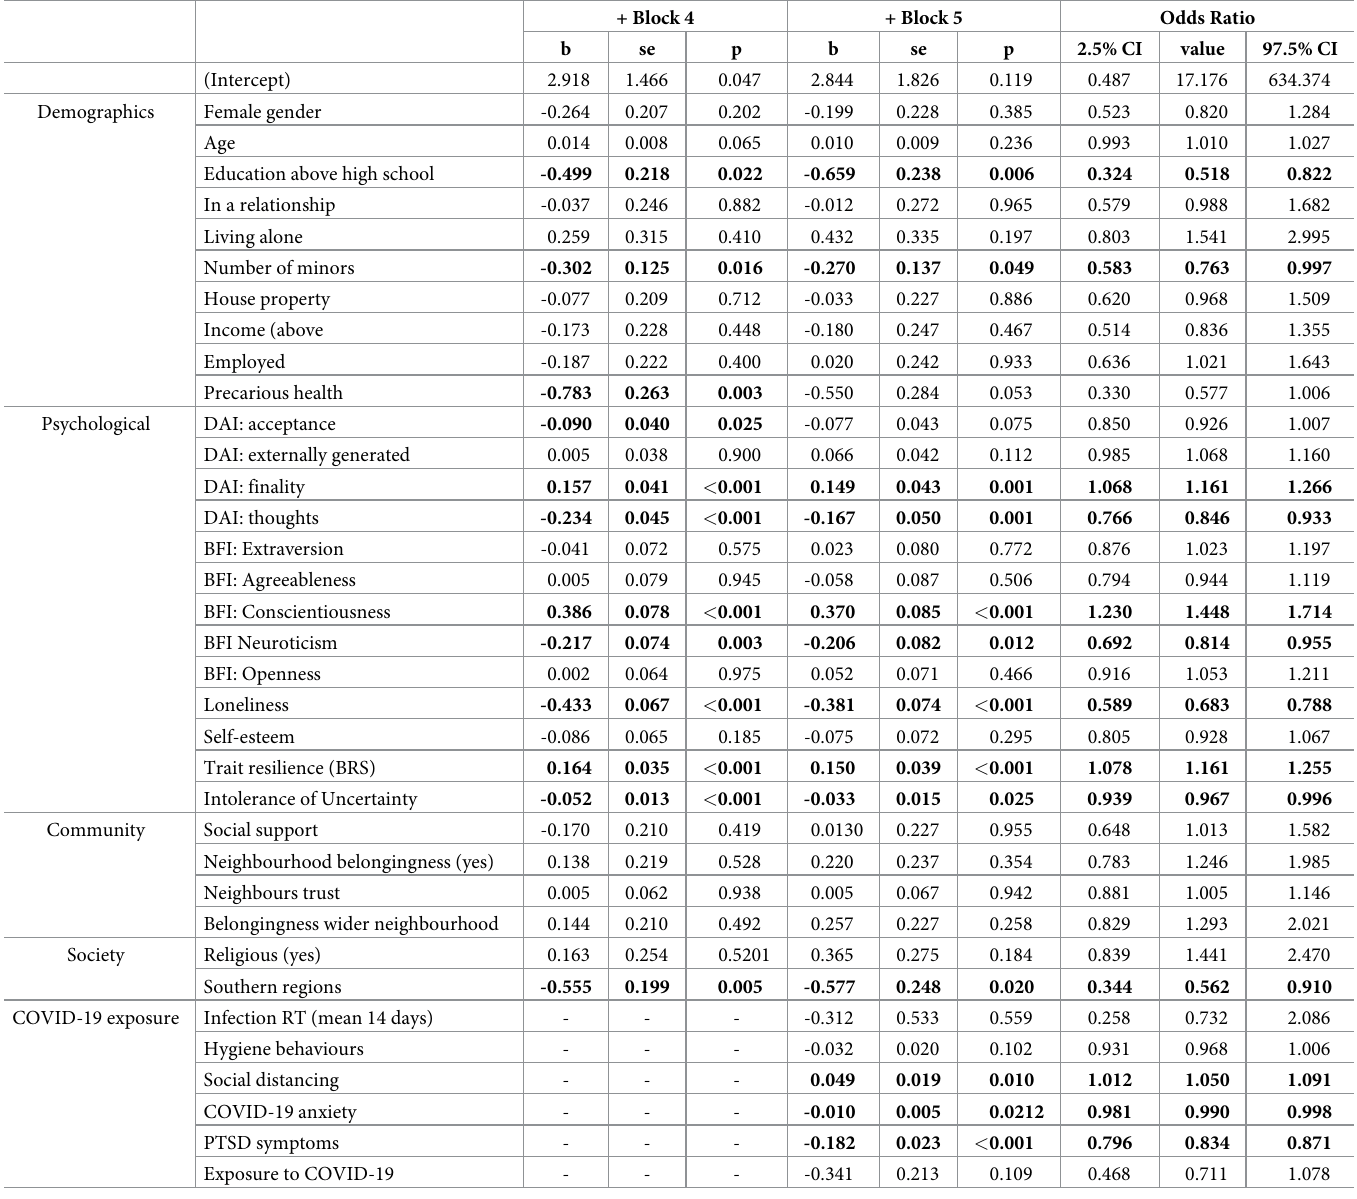
Table 5. Final regression model (Block